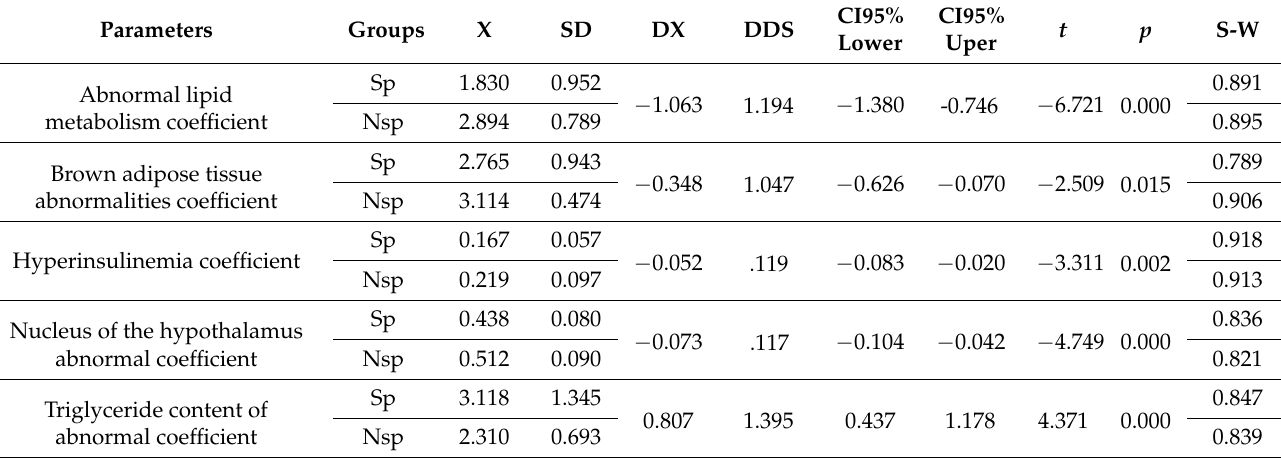
Table 5. Statistical analysis of the obesity analysis report for the female